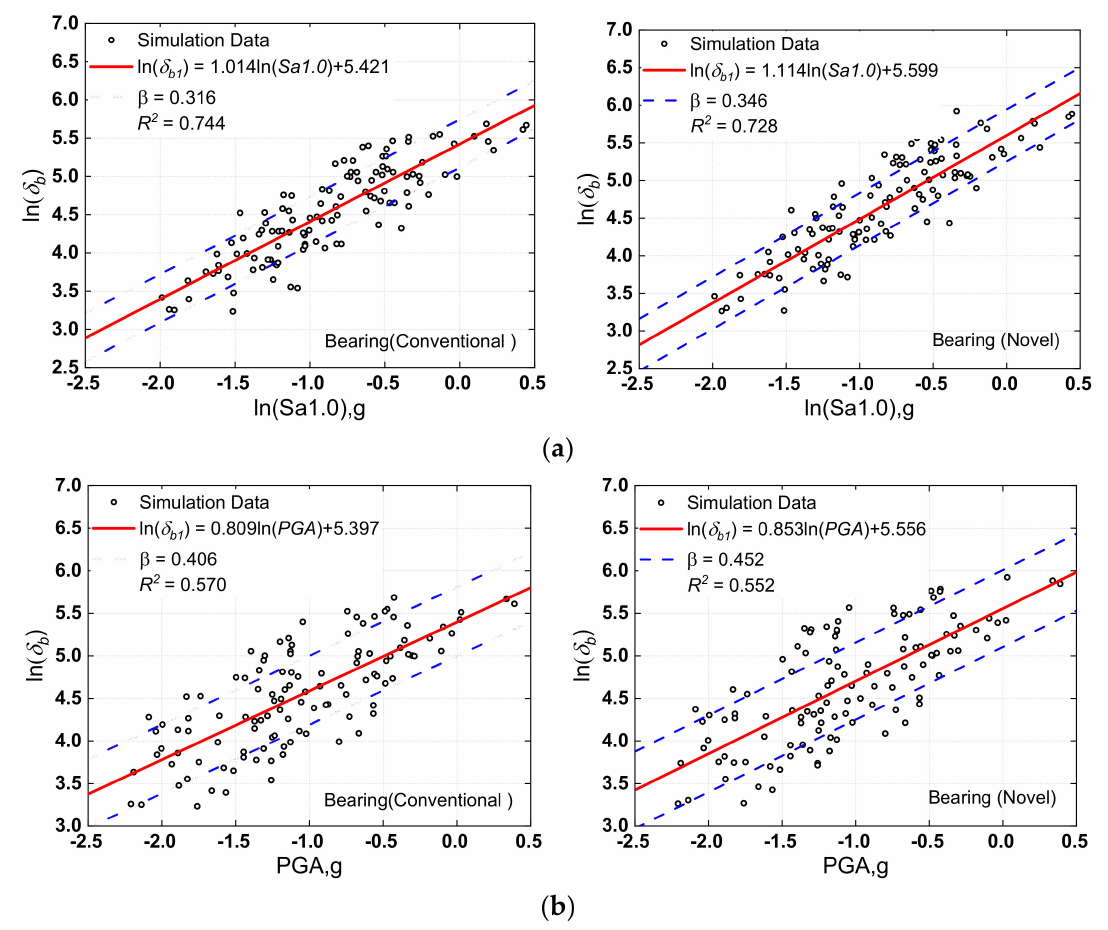
Figure 10. Probabilistic seismic demand models of bearing: ( a ) Sa1.0 versus bearing displacement responses, ( b ) PGA versus bearing displacement responses.